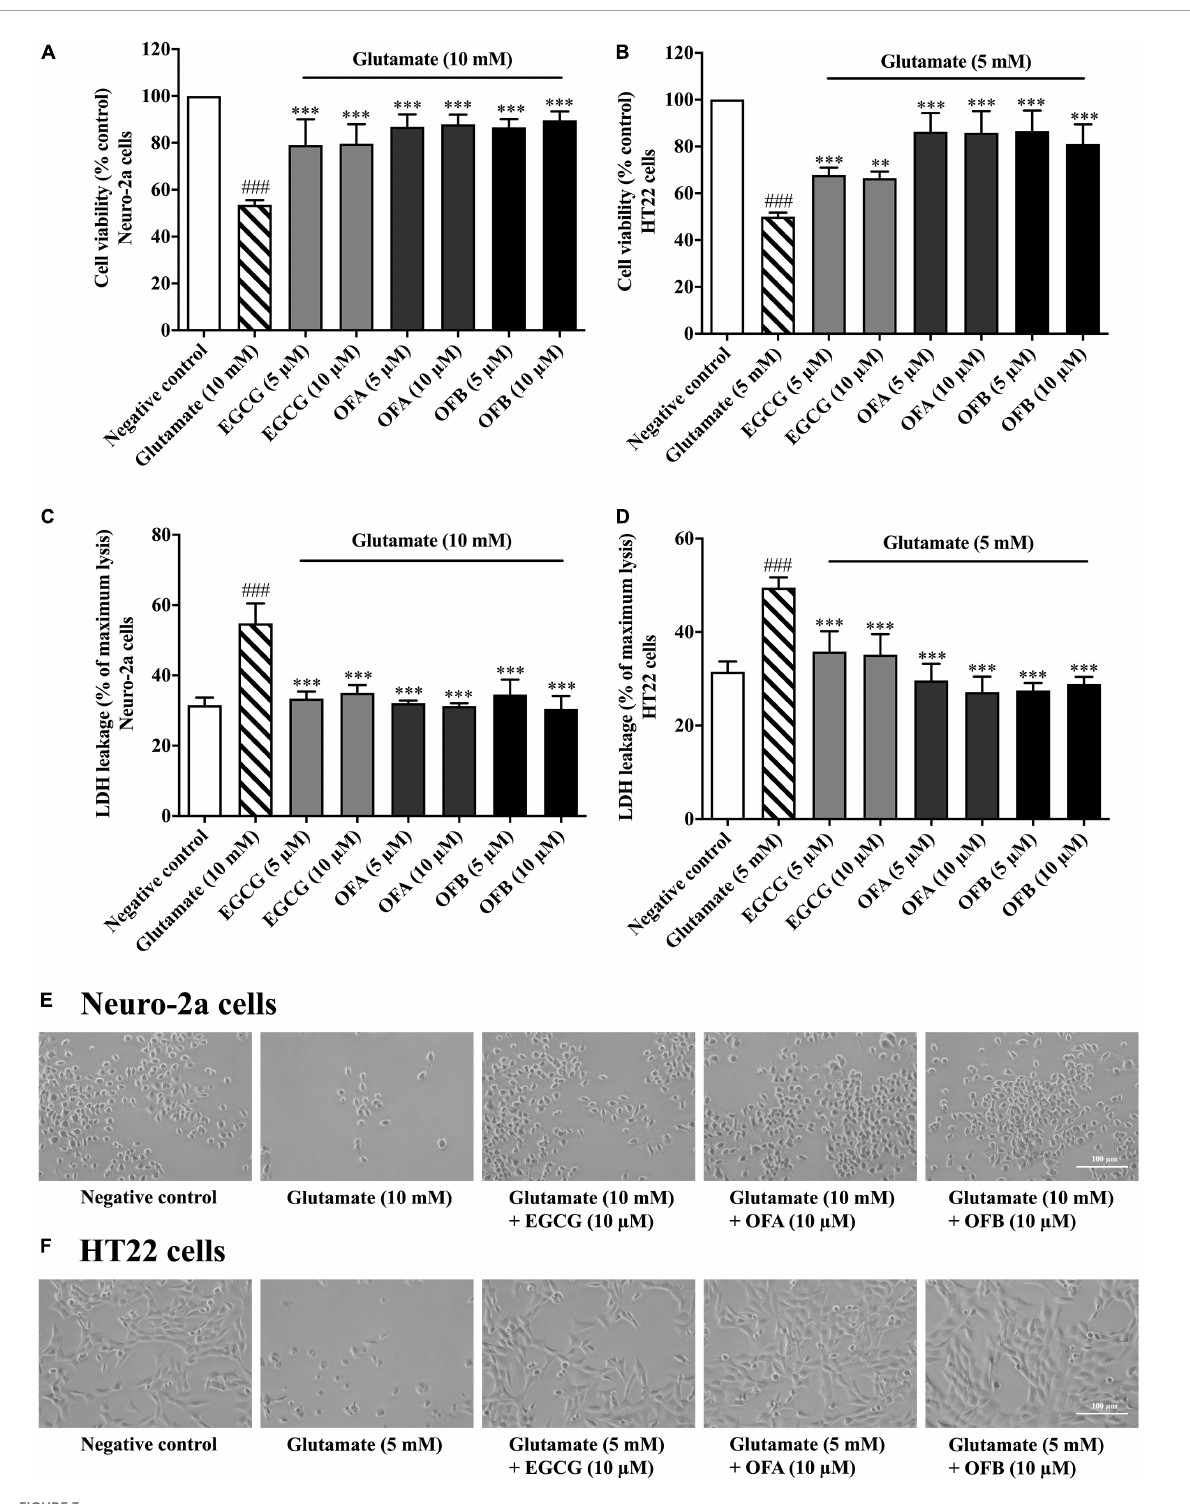
FIGURE3 Protective effects of EGCG, OFA, and OFB against glutamate-induced toxicity in Neuro-2a and HT22 cells. Cell viability after treatment with different concentrations of EGCG, OFA, and OFB and exposed to glutamate in Neuro-2a (A,C) and HT22 cells (B,D) . Samples were exposed to glutamate (5–10 mM) to induce toxicity. Cell morphology was also checked under a 5 magnification microscope (E,F) . Results are shown as the mean ± standard deviation ( n ≥ 3 independent experiments). ### p < 0.001 compared to the negative control; ∗∗ p < 0.01 and ∗∗∗ p < 0.001, compared to the glutamate treated